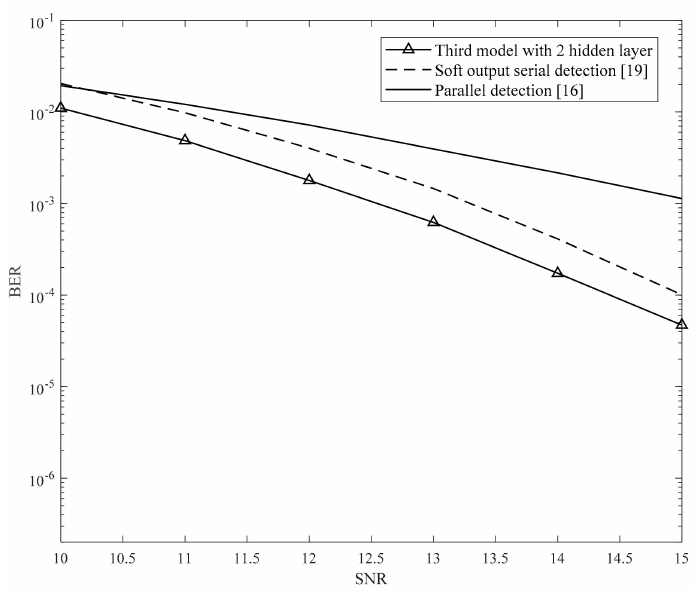
Figure 22. BER of the channel with 10% TMR and 6% position